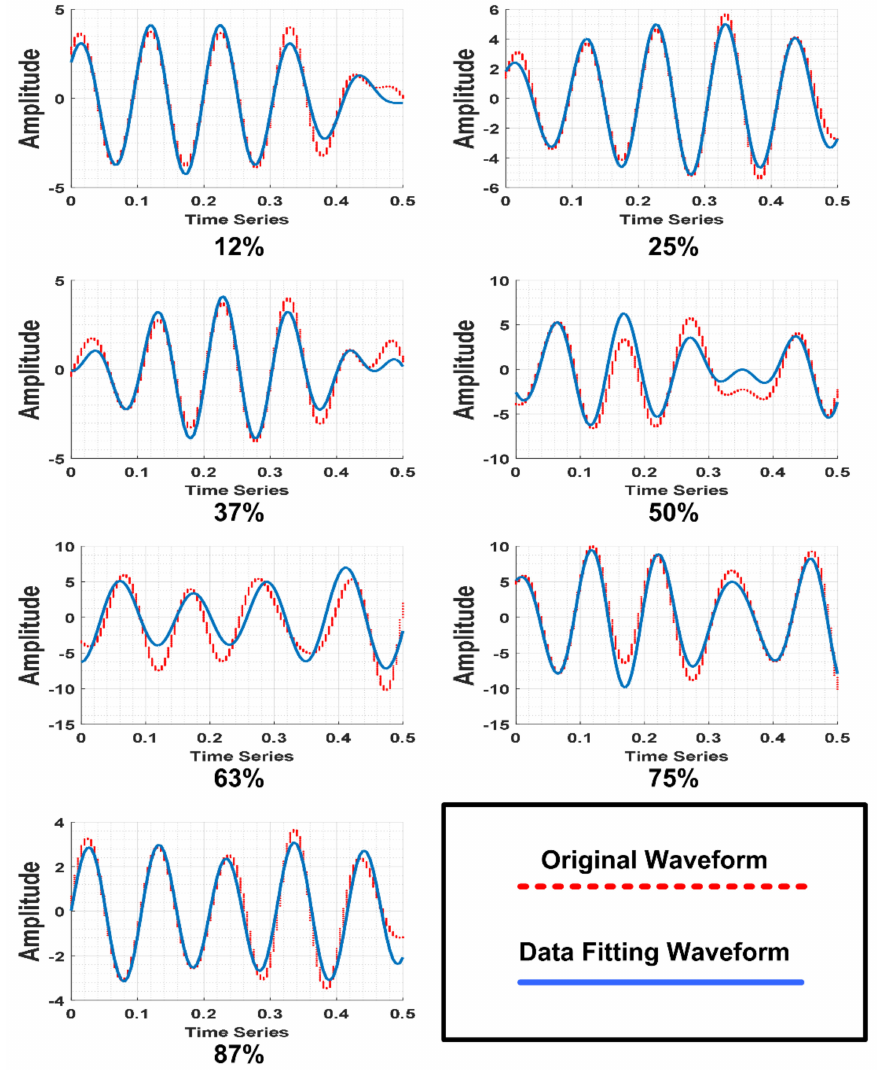
Figure 11. Comparison of the actual response and optimized mathematical model for the pipe with damage in axis